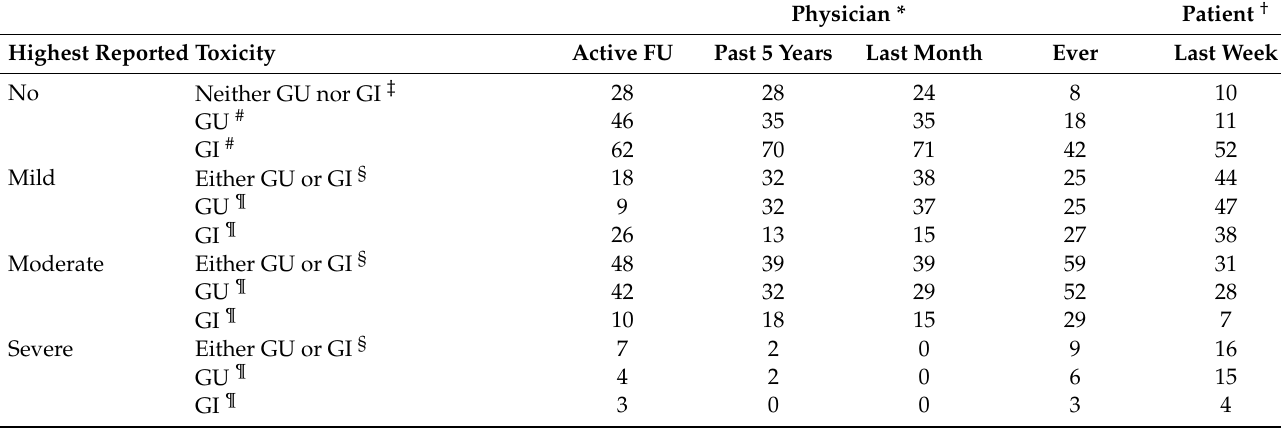
Table 4. Physician- and patient-reported toxicity in 101 prostate cancer patients treated with external beam radiotherapy between 2009 and